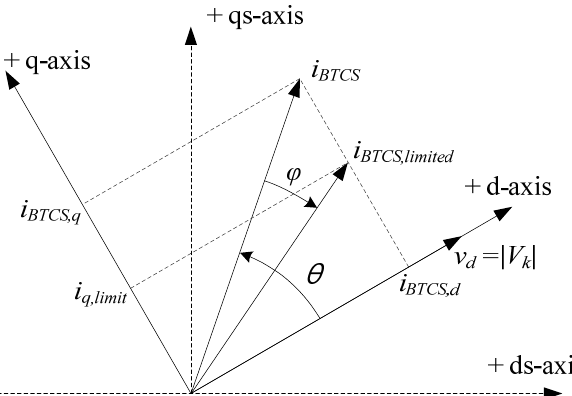
Figure 3. Voltage and current vectors in a rotating reference